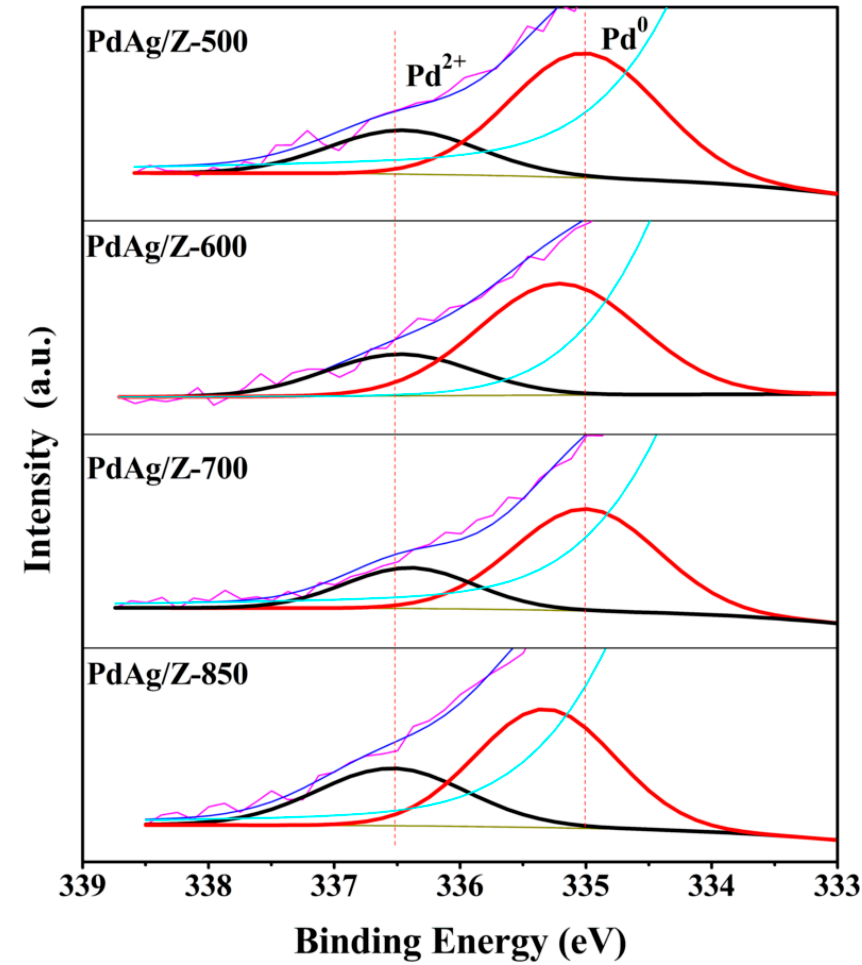
Figure 9. XPS curves of PdAg/Z alloy catalysts calcined at different temperatures. Table 1. Chemical state analysis from XPS characterization.